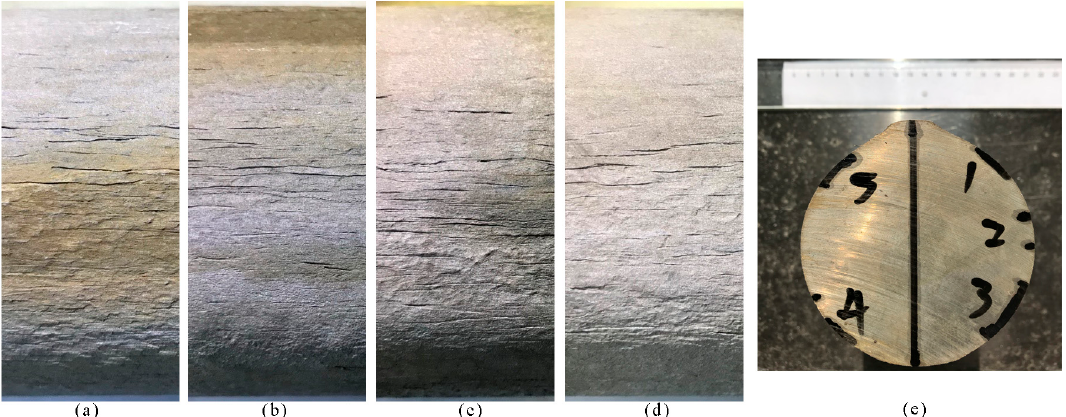
Figure 14. The morphology of surface wrinkle defects located at di ff erent positions and its distribution. ( a – d ) represent the morphology of surface wrinkle defects located at area 1, 3, 4 and 5, respectively. ( e ) The distribution of surface wrinkle defects in the cross section of the billet.